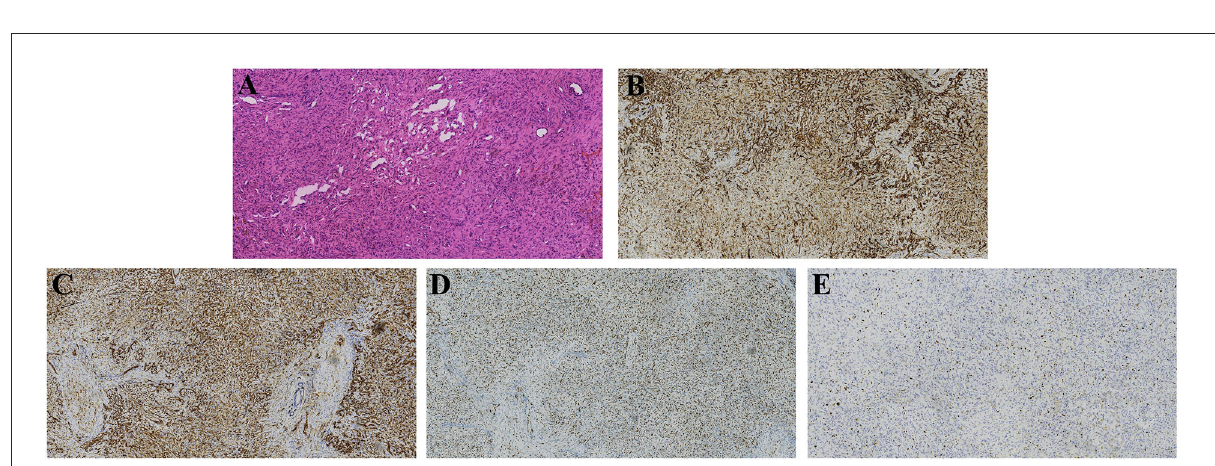
FIGURE3 Hematoxylin and eosin and immunohistochemical staining of the liver biopsy, which showed spindle-shaped tumor cells and epithelioid tumor cells [ (A) , hematoxylin and eosin, × 200], and positive for CD 31, CD34, and ERG [ (B–D) , respectively, × 200]. The index rate of Ki-67 was 20% [ (E) , ×